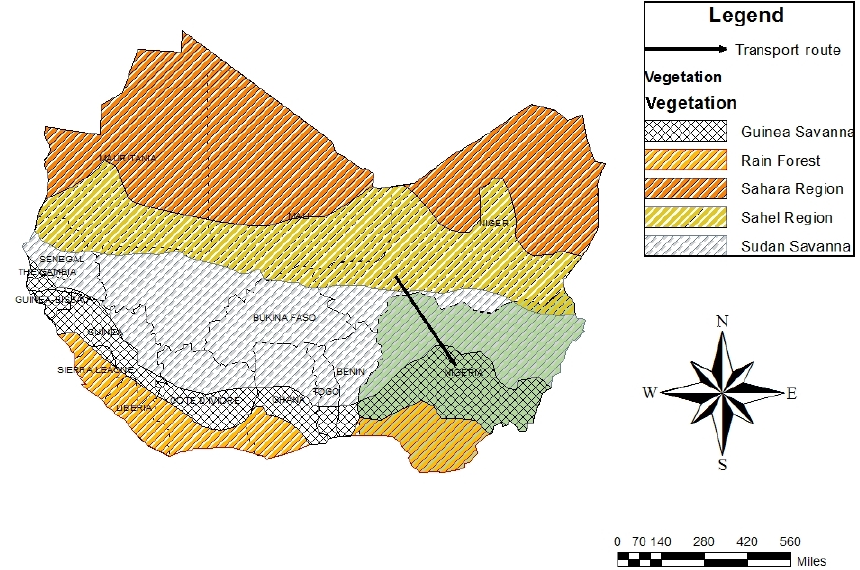
Figure 1. Map of West Africa indicating the geographical zones and transportation of Sahel goats. The map was carved and modified using a section of the map of Africa obtained from Bioclimatic Regions Map (https://eros.usgs.gov/westafrica/node/147) as a